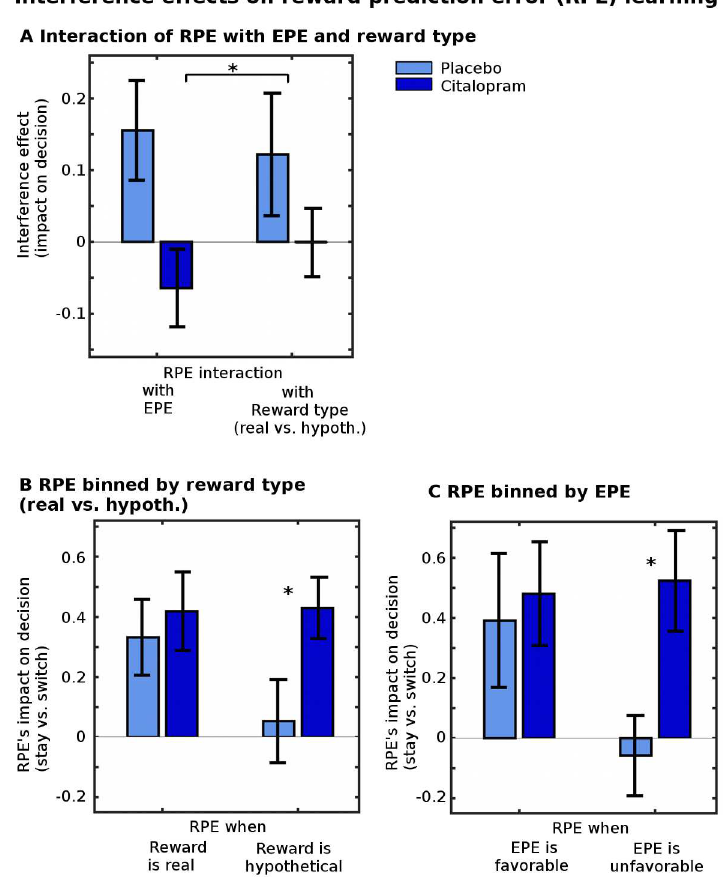
Fig 5. Citalopram protects reward learning from interference. (A) A regression analysis(bGLM2) assessedinterferencein rewardlearning(impact of relativeRPEs) by effort learning(relative EPEs) and rewardtype (receivinga real or only a hypothetical reward). Larger regressionweights indicatelarger interference. While the placebogroup’s learningwas affected by interferingfactors (ANOVA, testing the averagesize of the two interference factors against zero in the placebogroup: F(1,13) = 5.39, p = 0.033), this was remedied by citalopram(ANOVA, testing the averagesize of the two interferencefactors againstzero in the citalopram group: F(1,14) = 1.04, p = 0.32; ANOVA, testing whetherthe two groups differed in the average size of the two interferencefactors: F(1,27) = 7.00, p = 0.013). This effect can be illustrated more directly by comparing how much participantscould take RPEs into account for making decisionson the next trial when there was interference or when there was not (analysesbGLM3a and b). (B) When reward was real, the two groupsdid not differ in how well they could use RPEs (t(27) = − 0.47, p = 0.64). However, when rewardwas only hypothetical, the citalopramgroup was better at using RPEs (t(27) = − 2.21, p = 0.036). (C) Similarly, when EPEs were favorable, the two groups did not differ in how well they could use RPEs (t(27) = − 0.32, p = 0.75), but when EPEs were unfavorable,the citalopram group was better at using RPEs (t(27) = − 2.69, p = 0.012). Error bars show standard error of the mean, * p < 0.05. Data for individualparticipantscan be found in S5